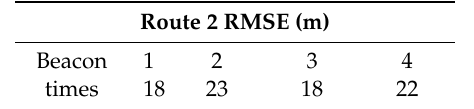
Table 6. RMSE of positioning with noise added to UWB range measurements.